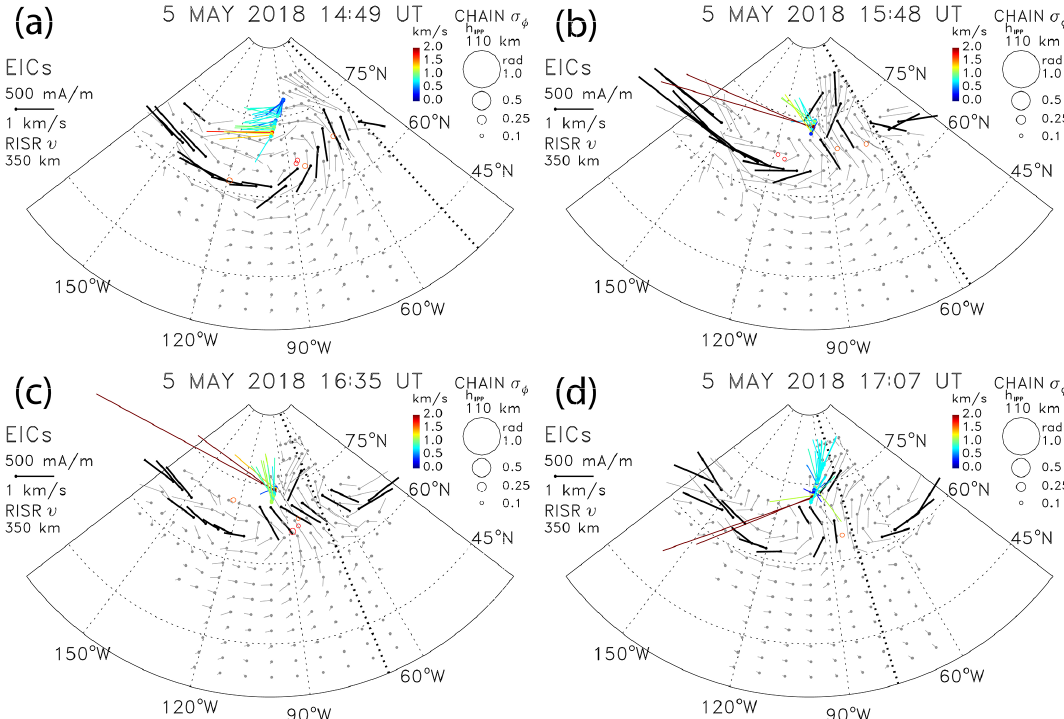
Figure 8. The same as Fig. 3 but for 5 May